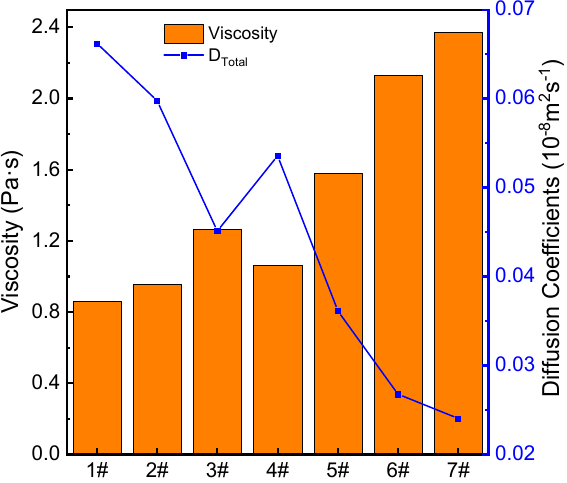
Figure 9. Effect of SiO 2 /Al 2 O 3 ratio on viscosity and total diffusion coefficients.